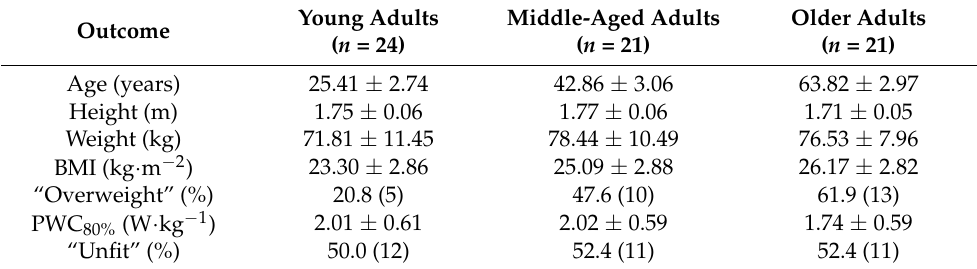
Table 1. Descriptive characteristics of the three age groups. Young Adults Outcome ( n =